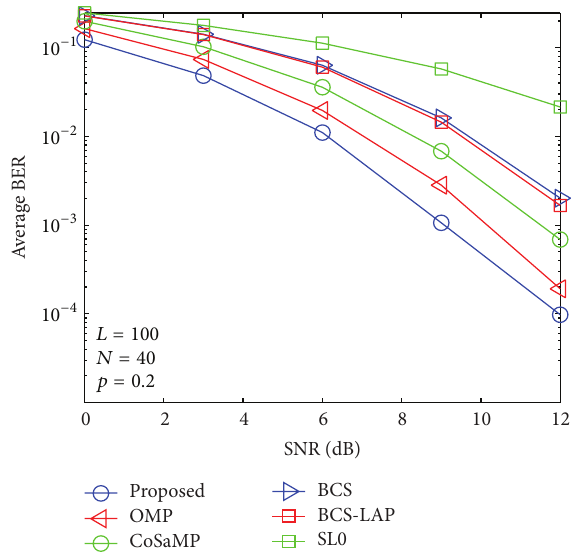
Figure 12: Average BER performance verses SNR when 𝑝 1 = 0.2 and 𝑁 = 40 .